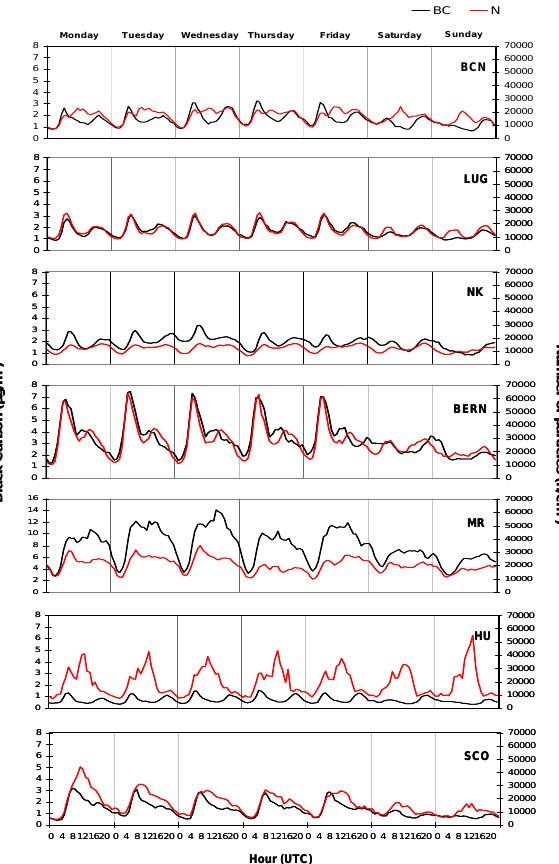
1 Figure 3. Daily cycle of BC and N for each day of the week. 2 3 Fig. 3. Daily cycle of: BC and N for each day of the week.